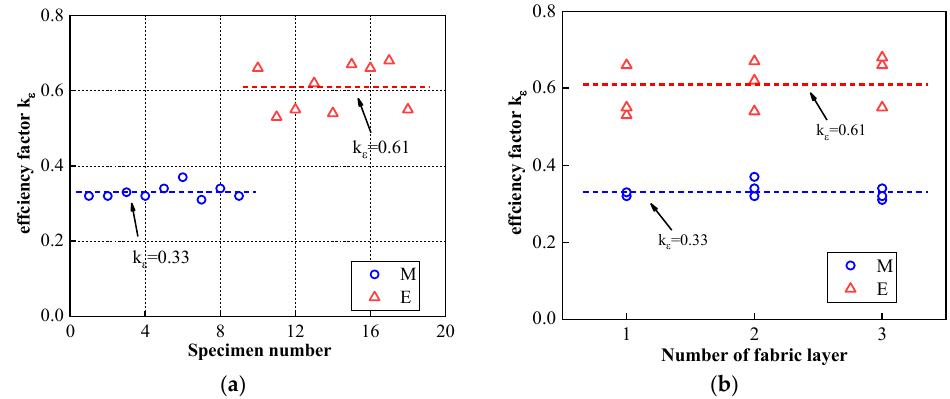
Figure 8. The impacts of ( a ) the binder type and ( b ) the number of fabric layers on the strain efficiency factor, k ε .